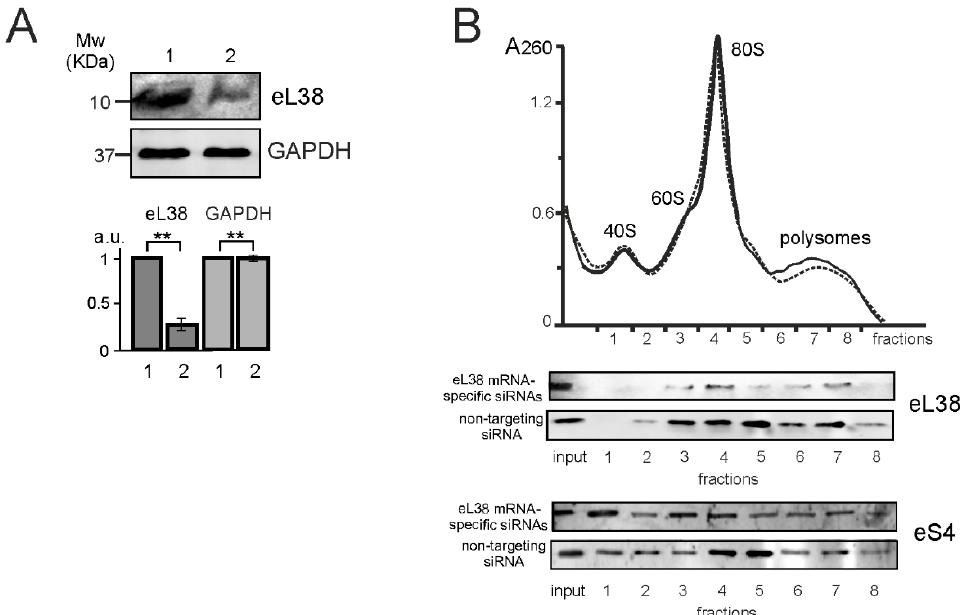
Figure 1. Ribosomal protein eL38 knockdown in HEK293 cells. ( A ) Western blot analysis of the levels of eL38 and GAPDH (as a reference) in cells transfected with siRNAs specific for eL38 mRNA (1) and non-targeting siRNA (2). The diagram shows triplicate western blot data as the mean of arbitrary units (a.u.) ± SEM (** p < 0.01, calculated using Mann-Whitney test). ( B ) Sucrose gradient polysome profiles obtained by the centrifugation of the lysates of cells transfected with non-targeting siRNA (solid line) and eL38 mRNA-specific siRNAs (dashed line); the peaks of 60S and 40S subunits, 80S ribosomes and polysomes are marked. Western blot analysis of the sucrose gradient fractions for the presence of ribosomal proteins eL38 and eS4 (as a reference).